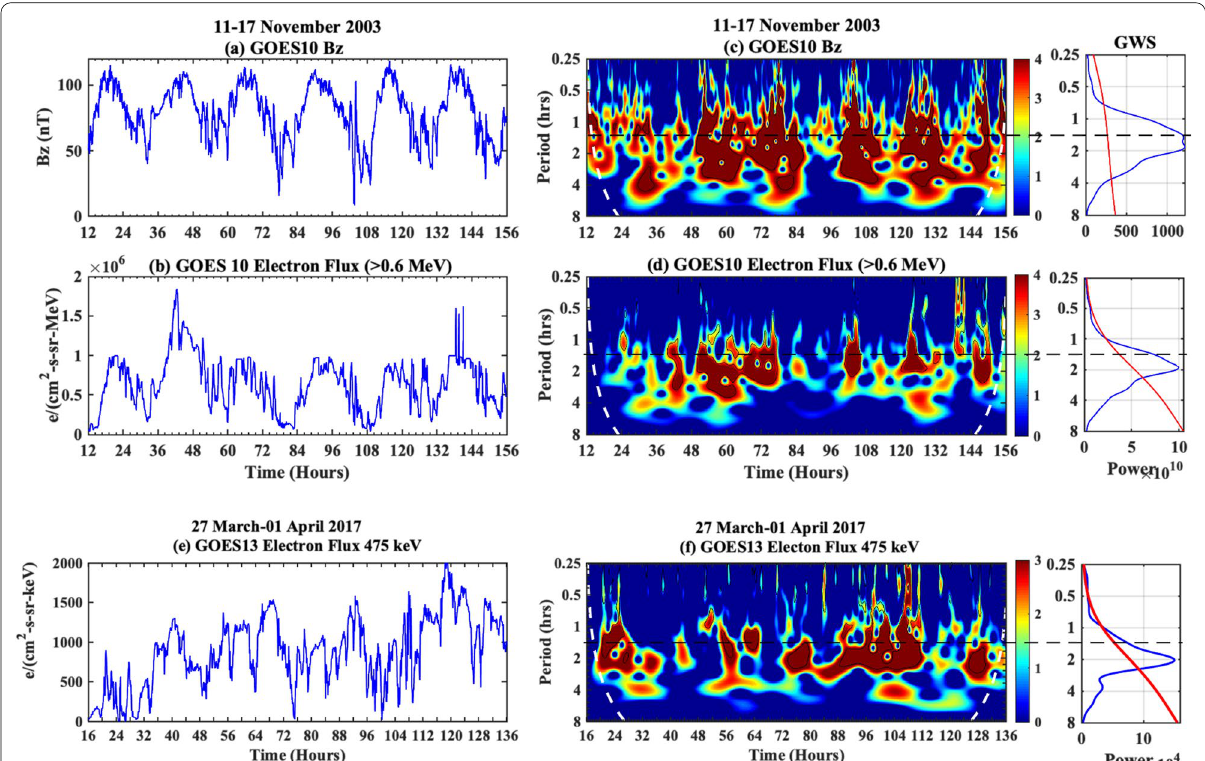
Fig. 5 This figure is similar to Fig. 2, but for the GOES measurements. a The temporal variations of the Z-component of the magnetic field, and b energetic electron flux (>0.6 MeV) at geosynchronous orbit measured by GOES-10 satellite and the corresponding wavelet spectra are provided on the right panel ( c and d ) for the 2003 event. e The temporal variations of electron flux for 475 KeV energy channel, and f its wavelet spectra for the 2017